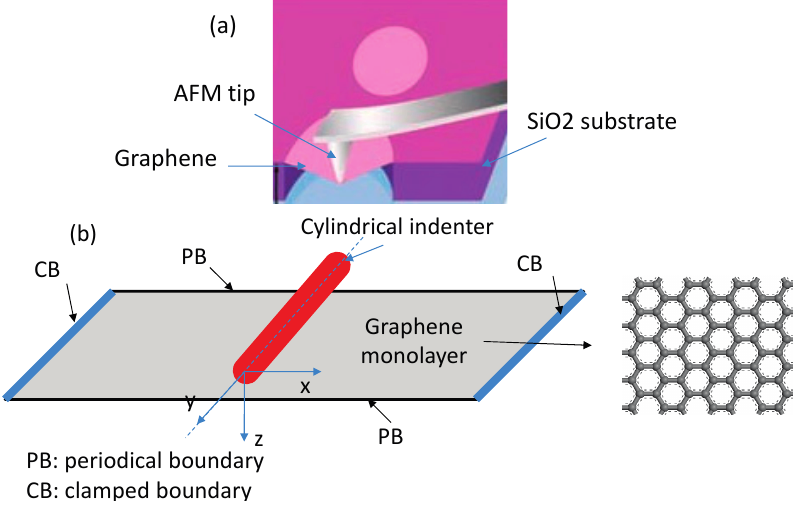
Figure 6. ( a ) Schematic of monolayer graphene under free standing indentation test acted by atomic force microscope (AFM); and ( b ) Schematic of the computational model of monolayer graphene under free standing indentation with a cylindrical